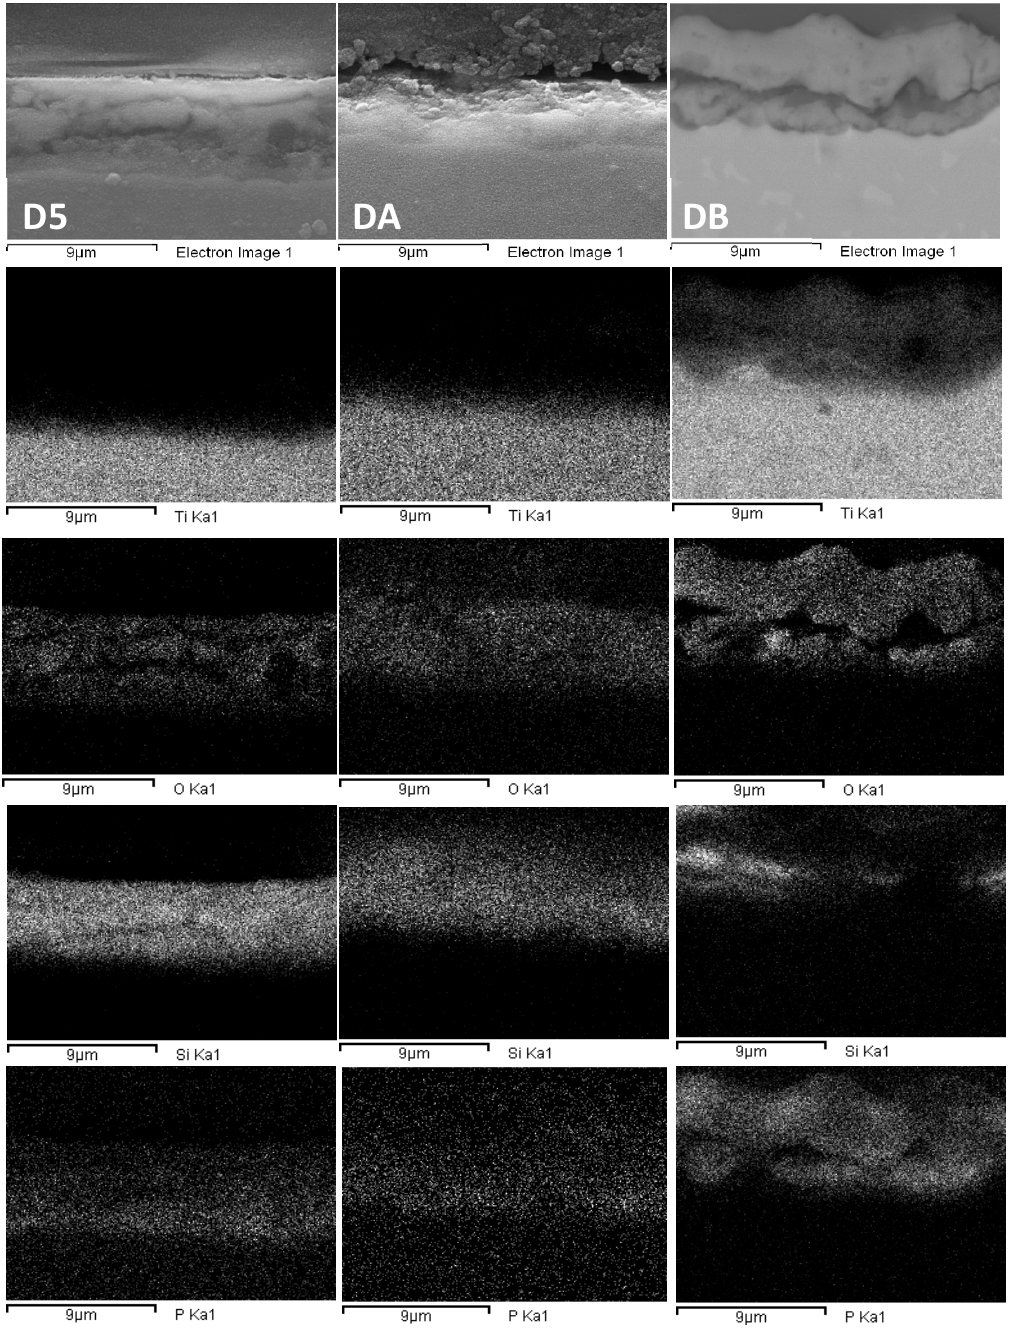
Figure 6. Polished cross sections and EDS X-ray maps of double layer PEO coatings (silicate bath followed by phosphate bath): D5 (top column), DA (centre column) and DB (right column). More information on deposition conditions of double layers can be found in Table 1. The X-ray maps were recorded for each coating in the same area of the electron image in the top